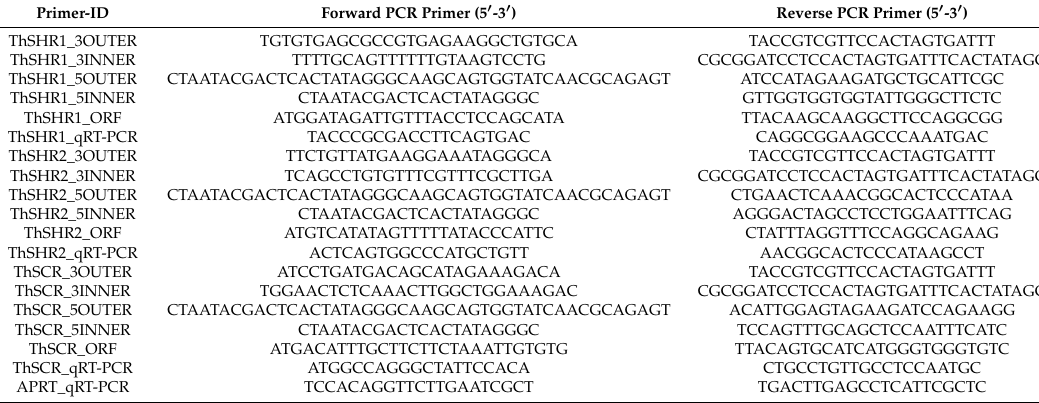
Table 1. Primer sequences of the genes for rapid amplification of cDNA ends (RACE), full-length open reading frames (ORFs) and real-time PCR